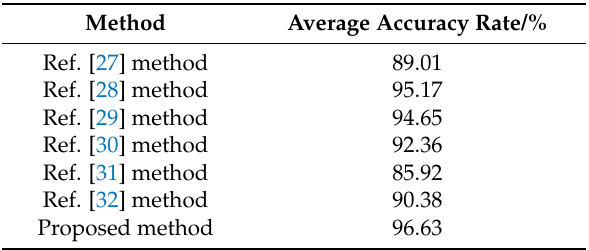
Table 3. Comparison of the proposed method with state-of-the-art methods in terms of average accuracy